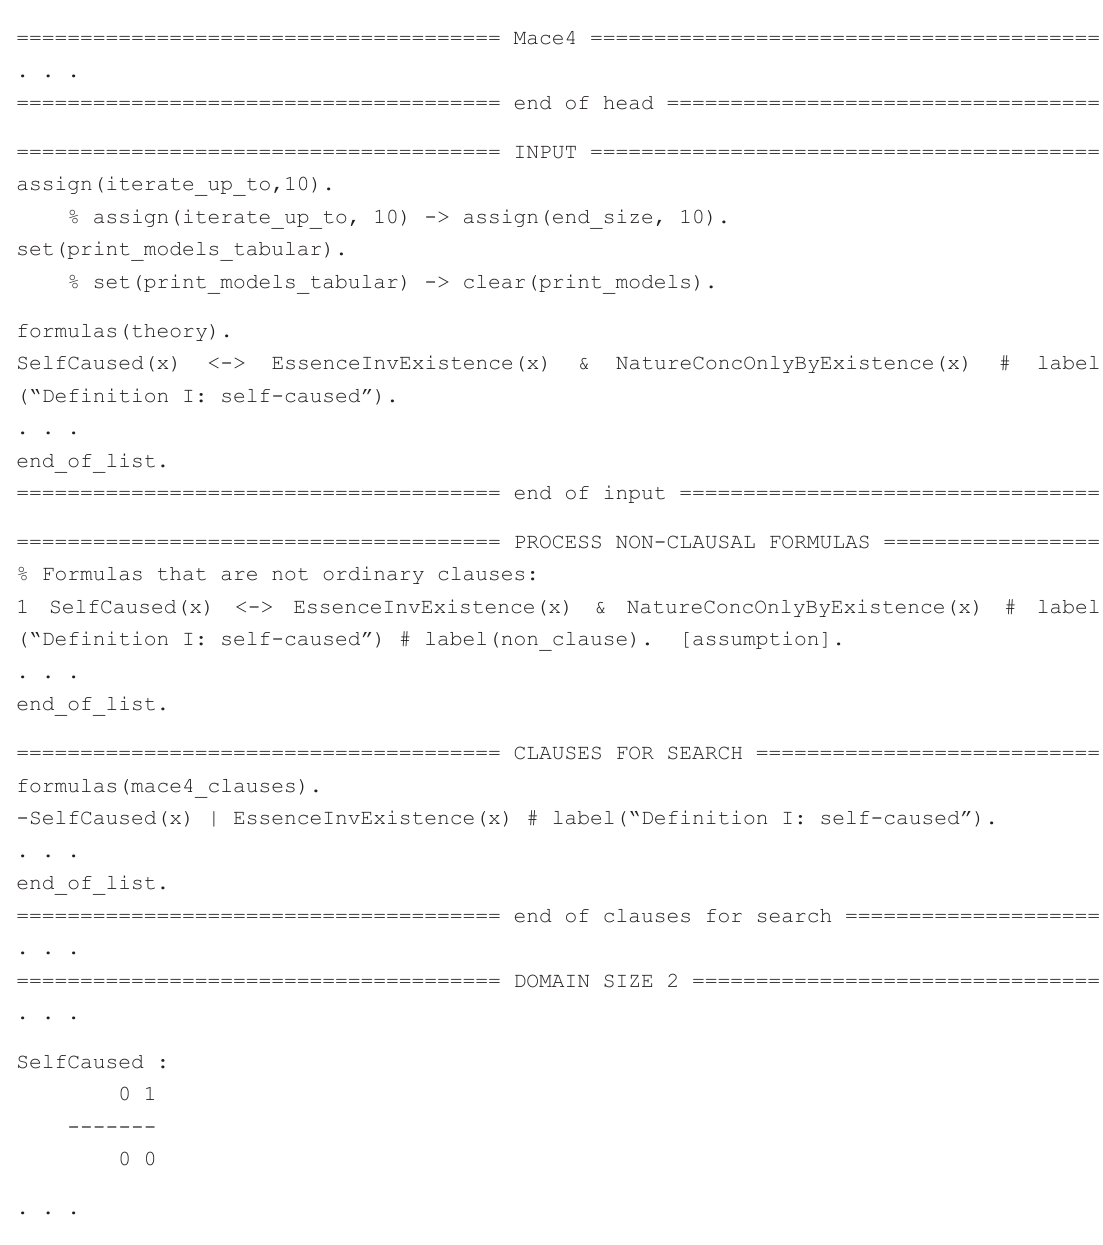
Figure 2: An excerpt from the mace4 output shown in Appendix 11. “. . .” indicates that I deleted text in mace4 ’s output at this